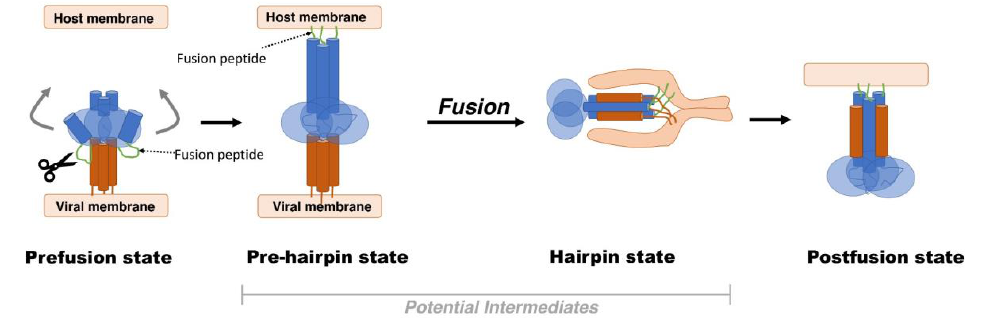
Figure 1. Model for membrane fusion; viral surface proteins undergo drastic conformational changes in order to bring the viral and host cell membrane close to each other. Upon its activation through proteolysis, the metastable prefusion state undergoes conformational changes in the fusion subunit that result in an intermediate state termed the “prehairpin” state [65–68]. At this point, the prehairpin structure can revert to its prior state in the absence of any membrane or irreversible transition to the postfusion state [48,69,70]. Finally, to prompt the fusion process, a short hydrophobic peptide or fusion peptide is released to connect with the target membrane. This interaction induces the formation of the six-helical postfusion state that brings the virus and host cell membranes in proximity and drives the membrane